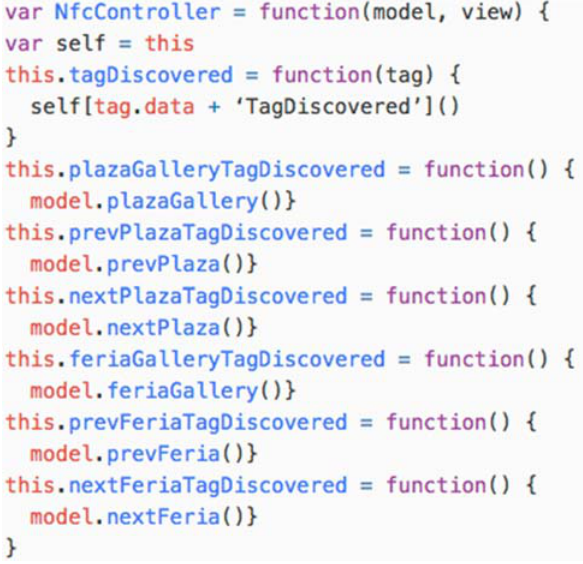
Figure 8. The view.js JavaScript file.